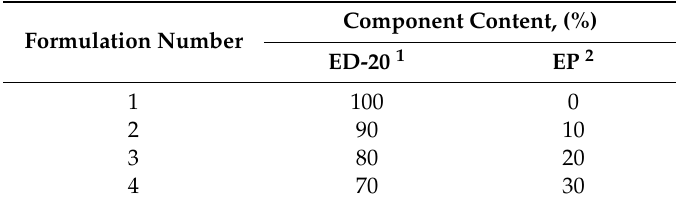
Table 1. Formulation of the mixtures.